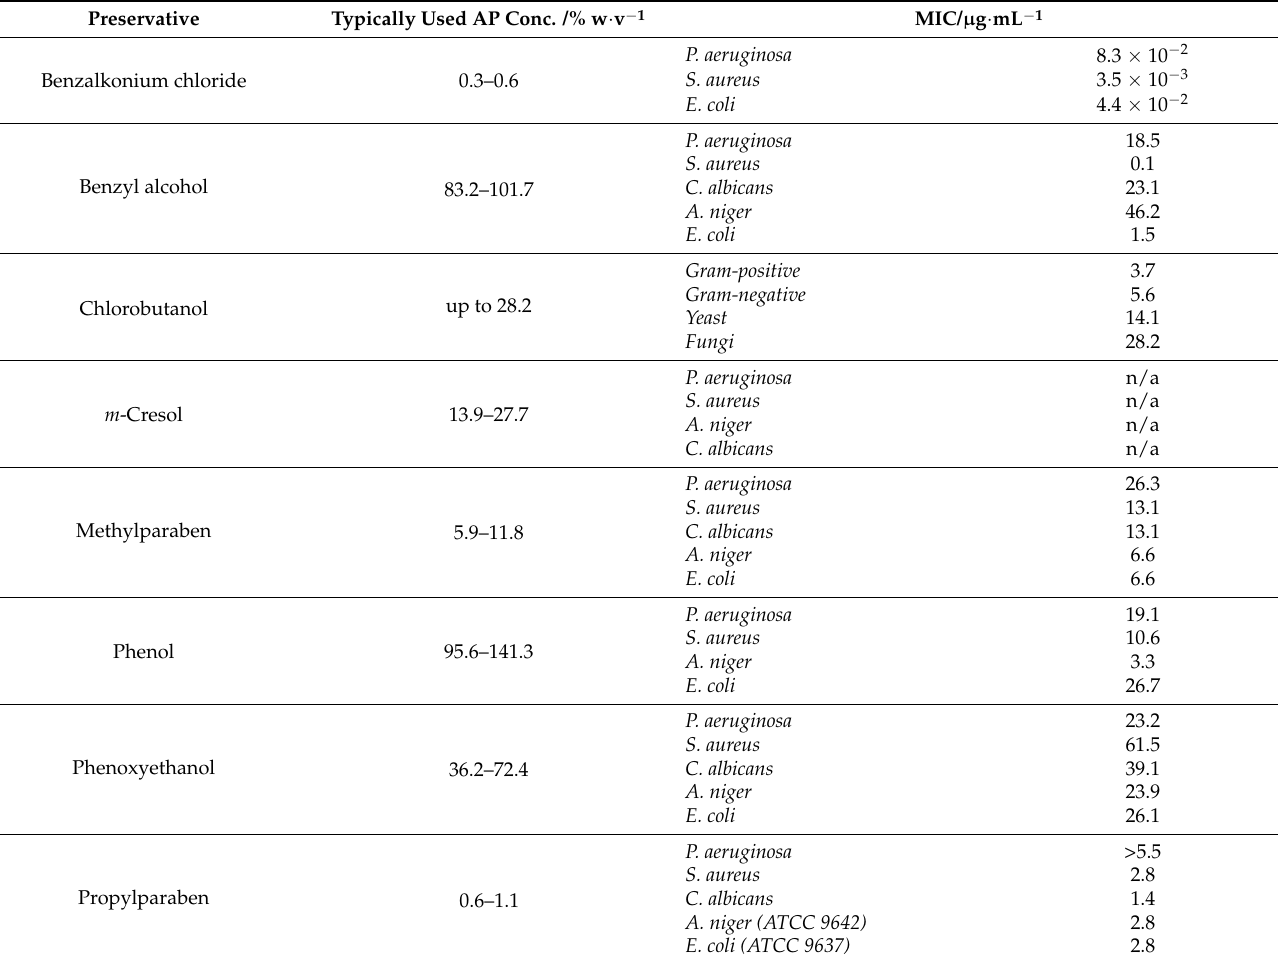
Table 5. Concentration range of antimicrobial preservatives in protein formulations and the MIC (minimum inhibitory concentration) values measured for microorganisms